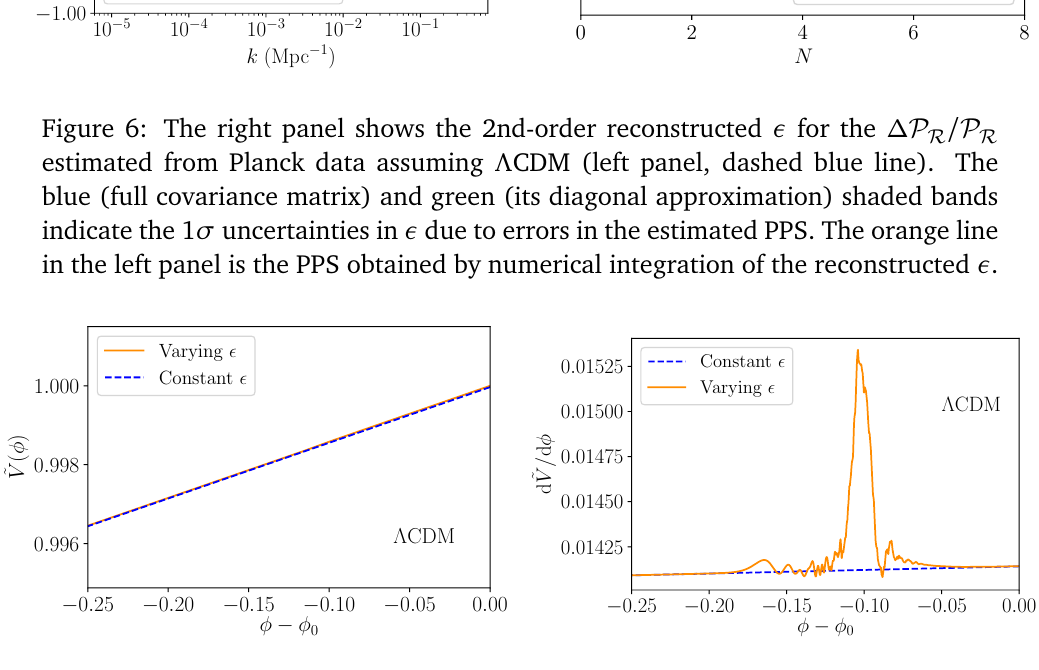
Figure 7: The left panel shows the potential ˜ V = V ( φ ) / V ( φ reconstructed ∆ ε/ε superposed on the attractor potential (dashed blue line) – the right panel is its